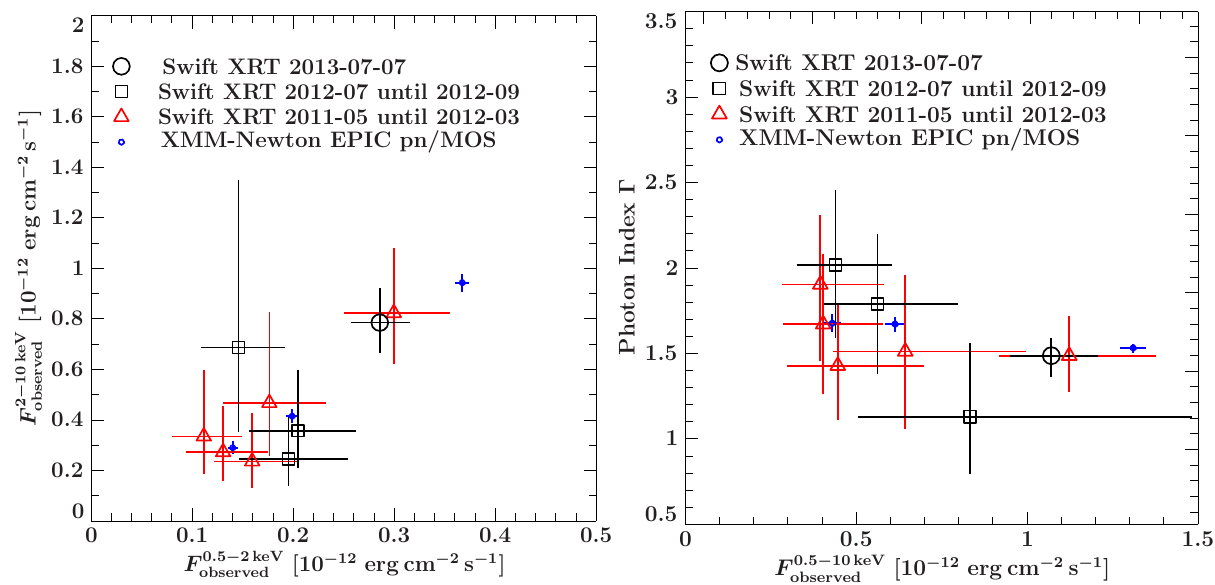
Figure 2. Hardness in the X-ray data of PKS2004 − 447. Left panel: Unabsorbed 2–10keV flux as a function of the 0.5–2keV flux. Right panel: Photon index of the absorbed powerlaw as a function of the unabsorbed 0.5–10keV flux.